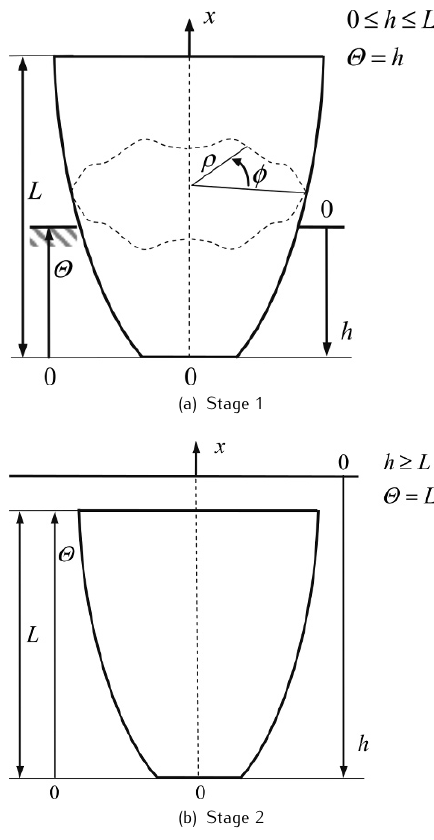
Figure 2. Two stages of penetration into a semi-infinite shield.